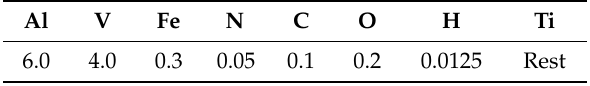
Table 1. Chemical composition table of titanium alloys w